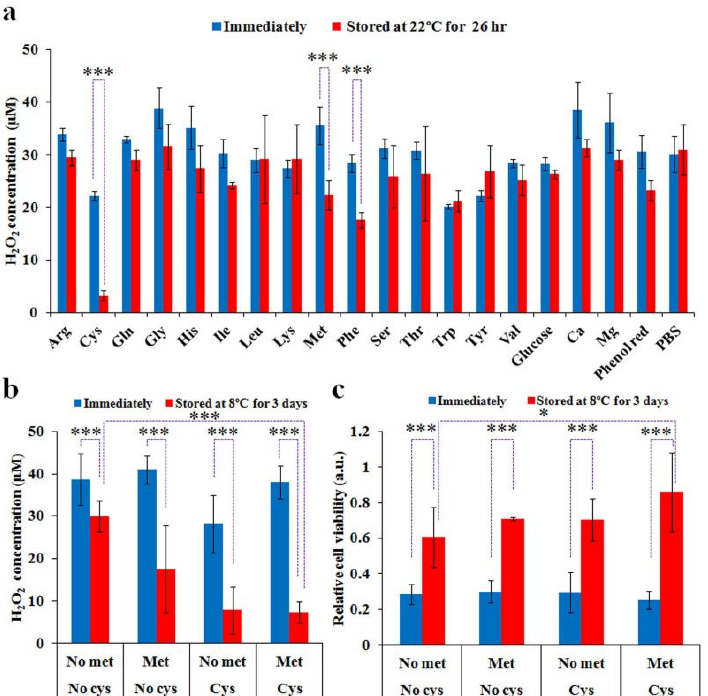
Figure 11. Cysteine and methionine mainly cause the degradation of PTS (cell culture medium) at 22°C and 8 °C. ( a ) The H 2 O 2 concentration in PTS (PBS) containing a specific component during the storage at 22 °C. ( b ) The H 2 O 2 concentration in the PTS (cys/met-free DMEM, cys-free DMEM, met-free DMEM, and standard DMEM) during the storage at 8 °C. ( c ) The anticancer effect of the PTS (cys/met-free DMEM, cys-free DMEM, met-free DMEM, and standard DMEM) after storage at 8 °C. Student’s t -tests were performed and the significance is indicated as * p < 0.05 and *** p < 0.005. Reproduced from [31]. Copyright 2016 Springer Nature.